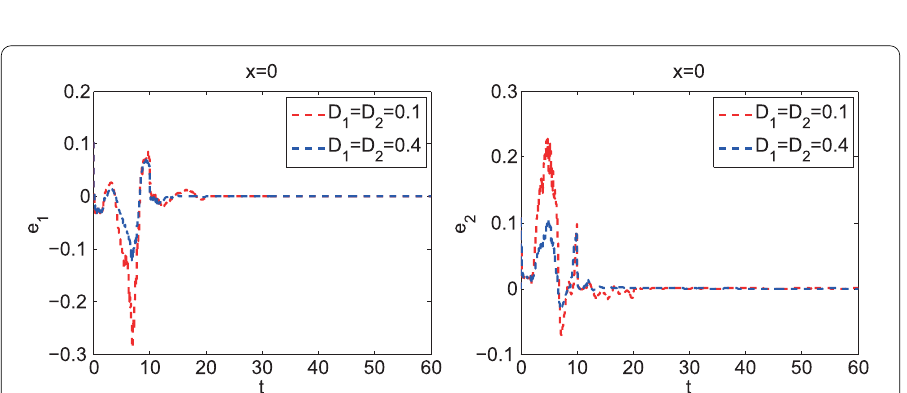
for reaction-diffusion Cohen-Grossberg neural networks to realize the synchronization by increasing diffusion coefficients or reducing diffusion space. Dynamic behaviors of the er- rors between systems (.) and (.) with differential diffusion coefficients and differential diffusion space are shown in Figures  and